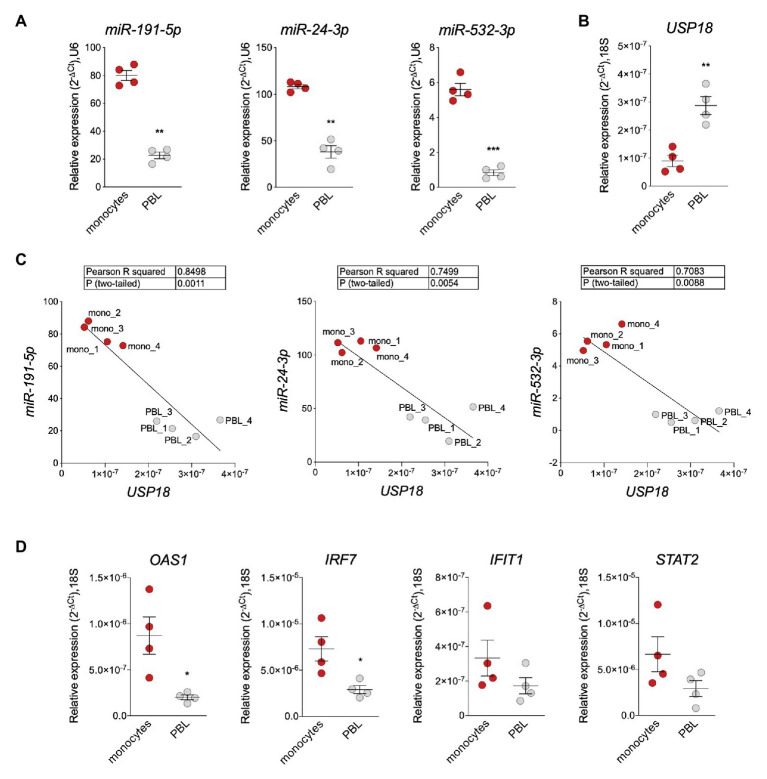
miR-191-5p, miR-24-3p, and miR-532-3p negatively correlate with USP18 in monocytes vs. PBL. (A,B) Expression of miR-191-5p, miR-24-3p, and miR-532-3p
(A) and of USP18
(B) in ex vivo monocytes and monocyte-depleted peripheral blood mononuclear cells (PBMCs; here PBL; four donors). Results (± SEM) shown as expression (2-ΔCt) relative to U6 or 18S, used as housekeeping genes. Paired t-test values of p shown as stars **p < 0.01, ***p < 0.001. (C) Negative correlation between USP18 and miR-191-5p, miR-24-3p, and miR-532-3p in monocytes and PBL. Expression levels used to calculate the correlation are shown in (A,B). Pearson correlation coefficients and p-values (two-tailed) are shown above. (D) Expression of OAS1, IRF7, IFIT1, and STAT2 in monocytes and PBL (four donors). Results (± SEM) shown as expression (2-ΔCt) relative to 18S. Paired t test p-values are shown, when significant, as stars *p < 0.05.